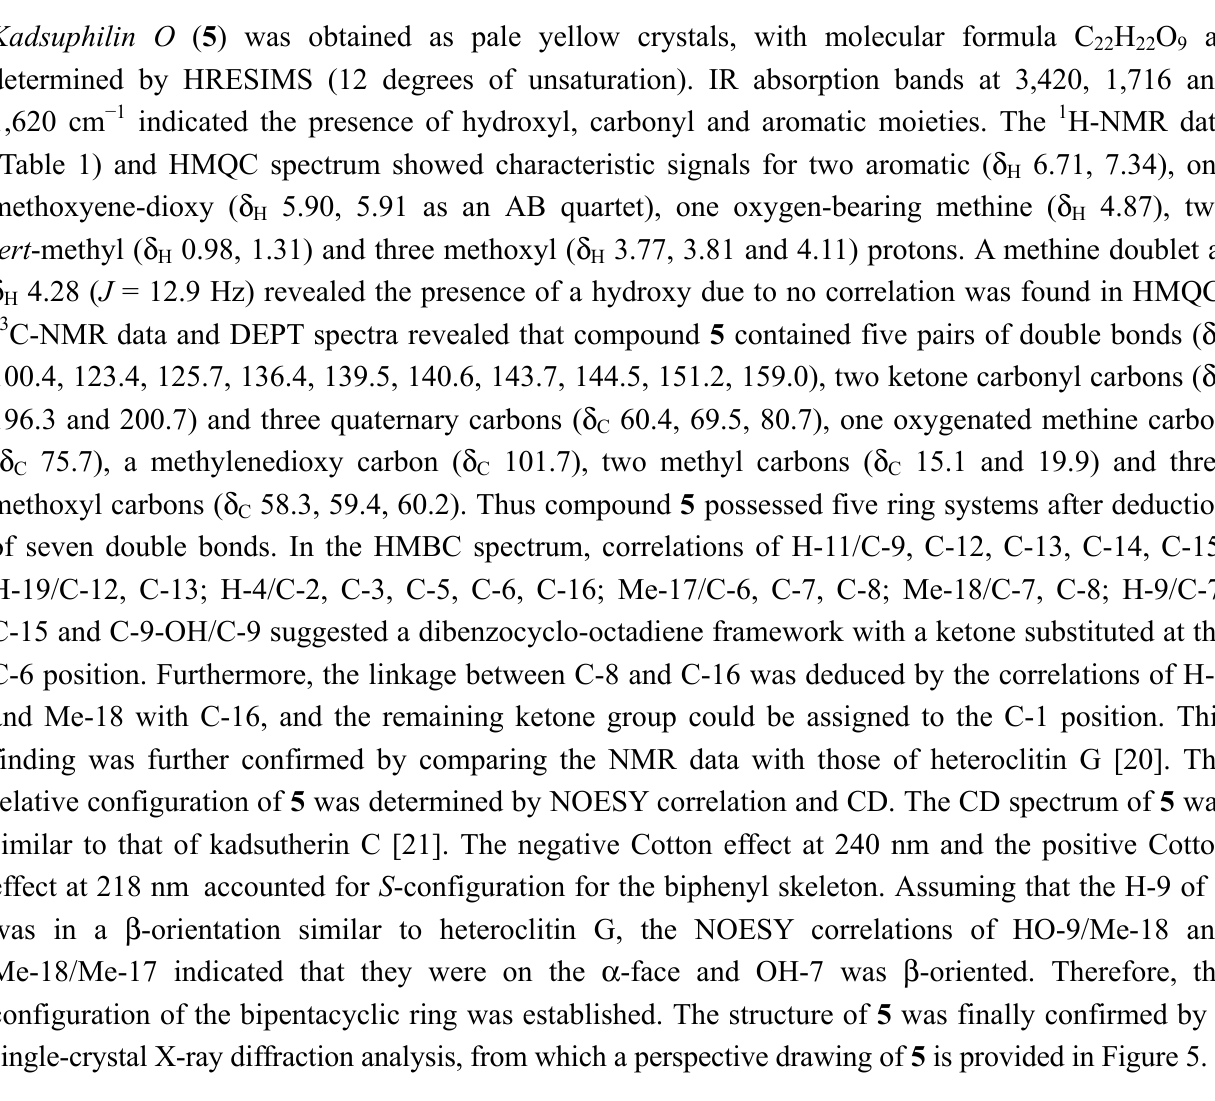
Figure 5. Selected HMBC correlations and X-ray perspective drawing of 5